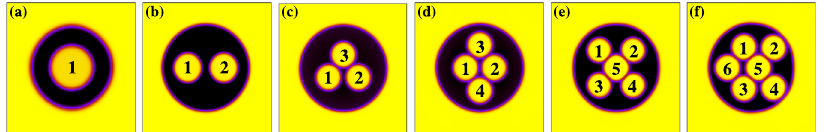
Fig. 2 Equilibrium states of multi-core emulsions. Equilibrium con fi gurations of a single-core ( a ), a two-core ( b ), a three-core ( c ), a four-core ( d ), a fi ve- core ( e ), and a six-core ( f ) emulsion. Droplet radii are as follows: R i = 15, R O = 30 ( a ), R i = 17, R O = 56 ( b – f ).